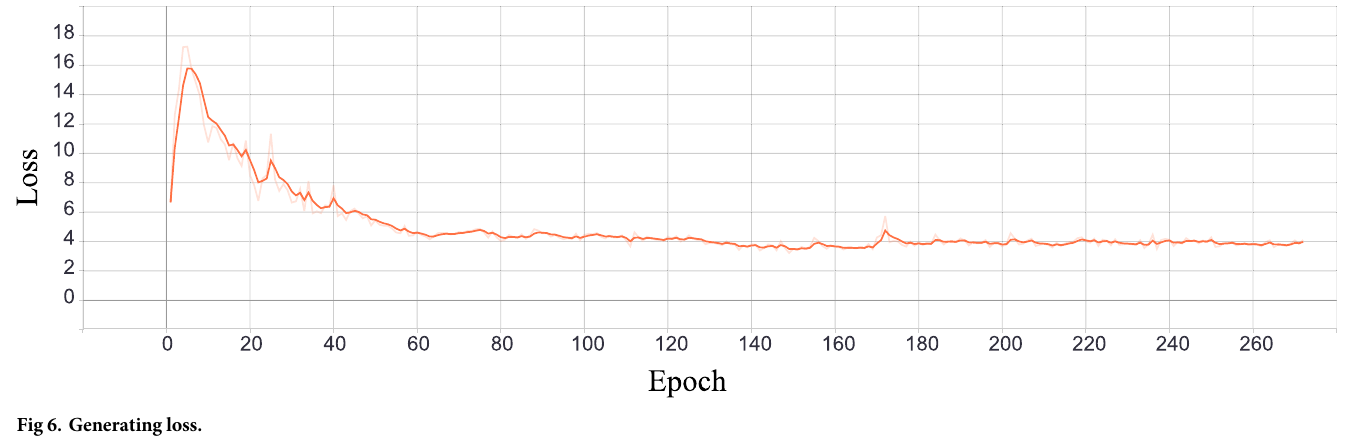
Fig 6. Generating loss.